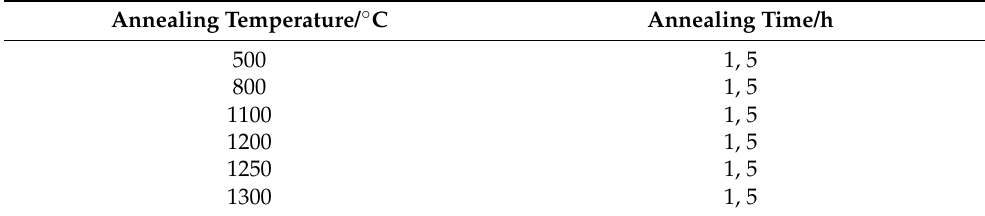
Figure 8. Temperature and velocity variations with differences in ( a ) current, ( b ) primary gas, ( c ) second gas, and ( d ) spraying distance. Table 4. Summary of the annealing parameters of the Si layer.